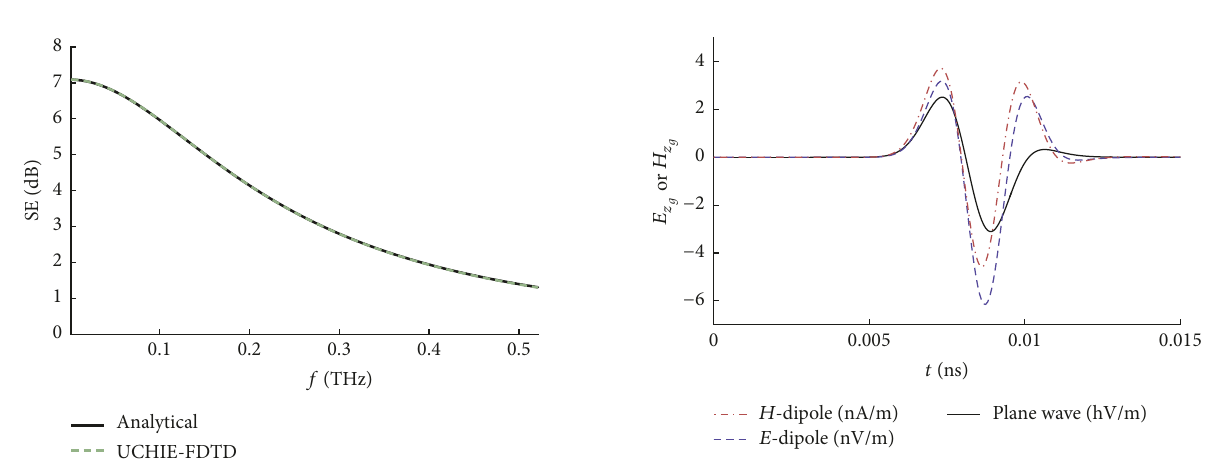
Figure 5: Shielding effectiveness of the 1 nm graphene sheet illuminated by a normally incident plane wave.